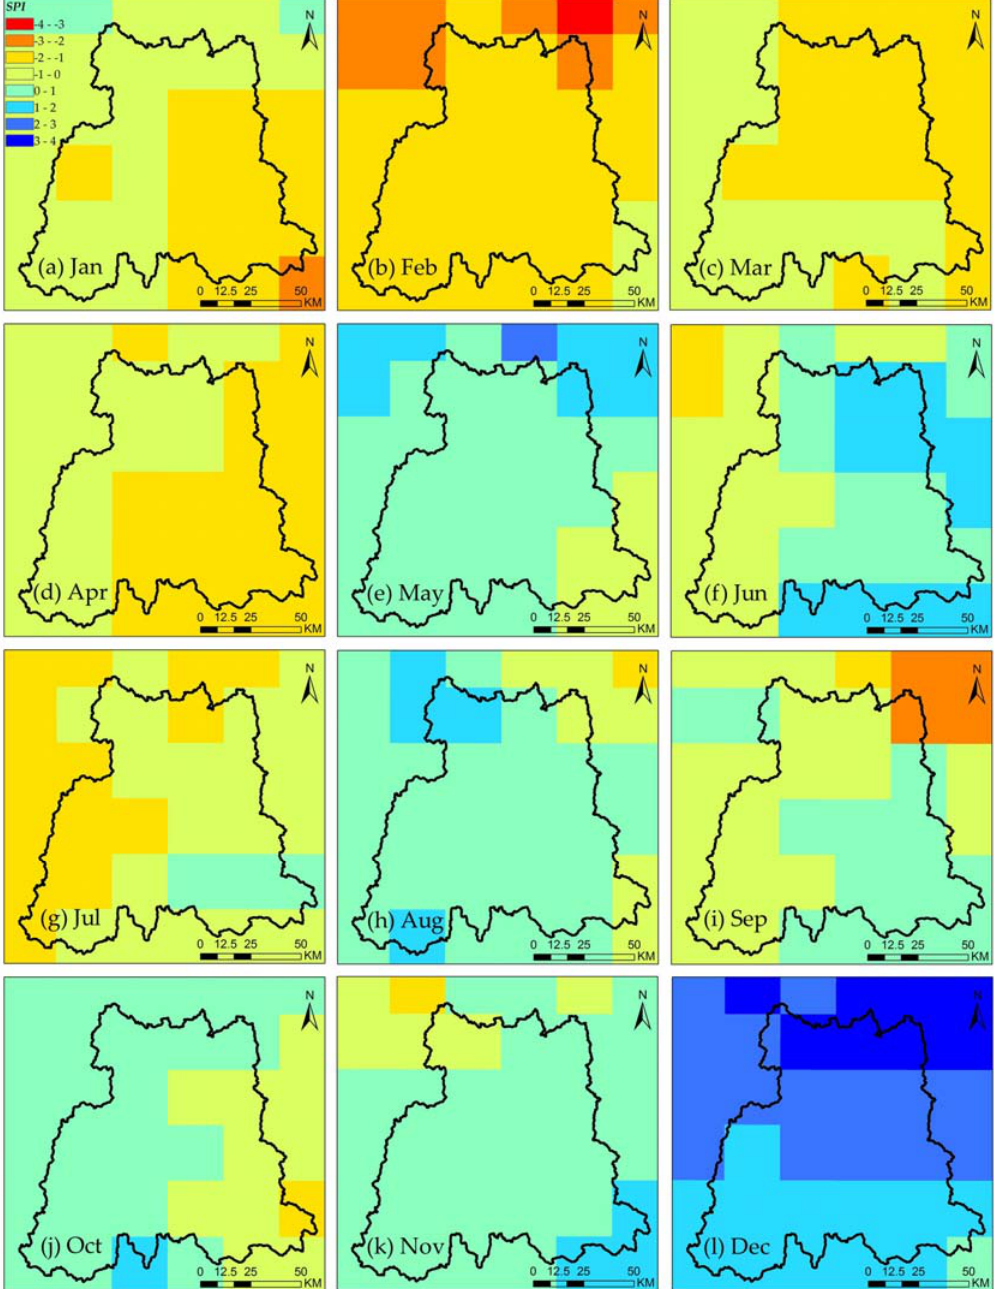
Figure 9. Drought monitoring based on the TMPA-3B43 one-month Standardized Precipitation Index (SPI) for ( a ) January; ( b ) February; ( c ) March; ( d ) April; ( e ) May; ( f ) June; ( g ) July; ( h ) August; ( i ) September; ( j ) October; ( k ) November; and ( l ) December in 2014 in the Kelantan River Basin.